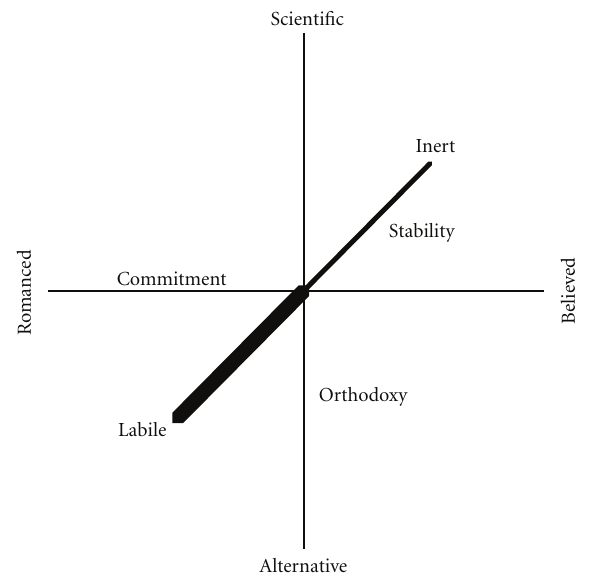
Figure 1: Some dimensions of learners’ ideas in science (from